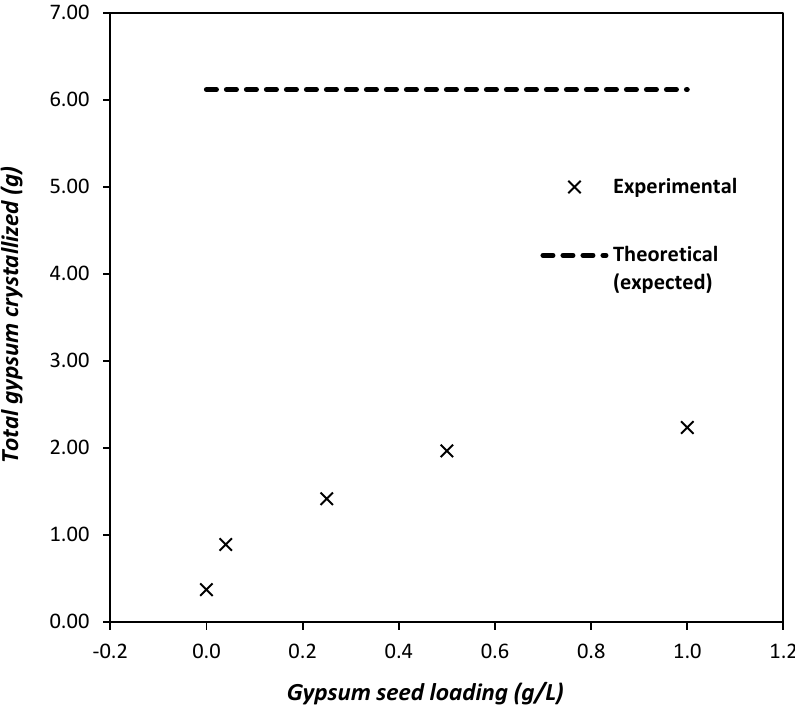
Figure 10. Total mass of gypsum crystallized as a function of gypsum seed loading.